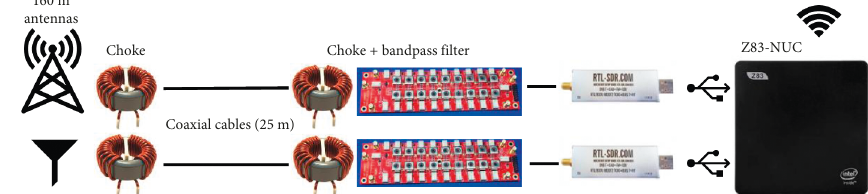
Figure 3: Double identical WSPR receiver setup using two RTL dongles connected to two different 160-m antennas (adapted shorted dipole and the ITA LWA II).